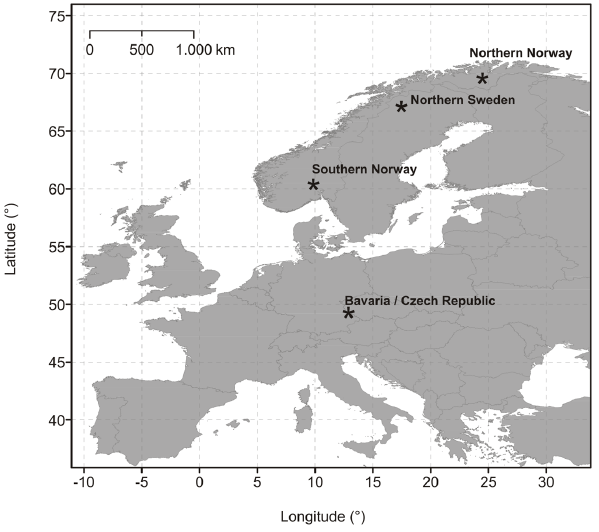
Fig. 1. Map of Western Europe with the locations of the four study sites. (See S1 Table ‘‘General characteristics of the study sites’’, for a detailed description).